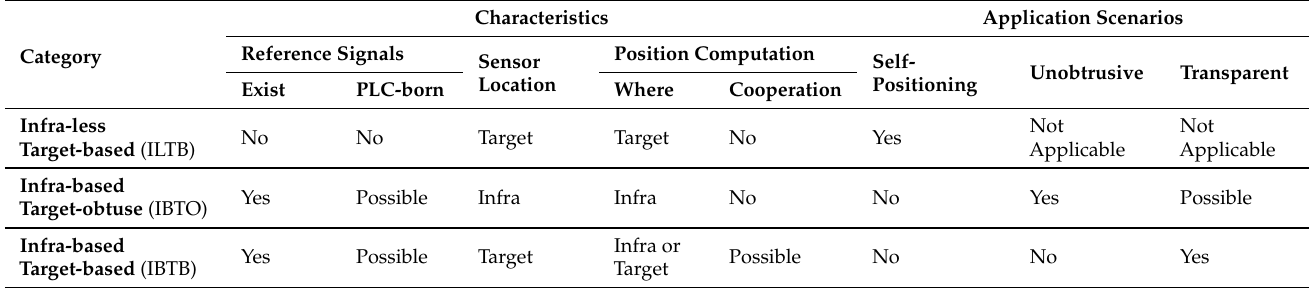
Table 1. Categories, characteristics, and broad application scenarios of positioning systems using the mains. The category indicates if the PLPS employs specific infrastructure to produce and inject reference signals or not (based × less) and if the target is involved in the positioning process or not (based × obtuse). The characteristics specify if and where the reference signals are produced, if they may come from PLC, which system part collects the positioning features, and where is the position resolved. The application scenarios are self-, unobtrusive, and transparent